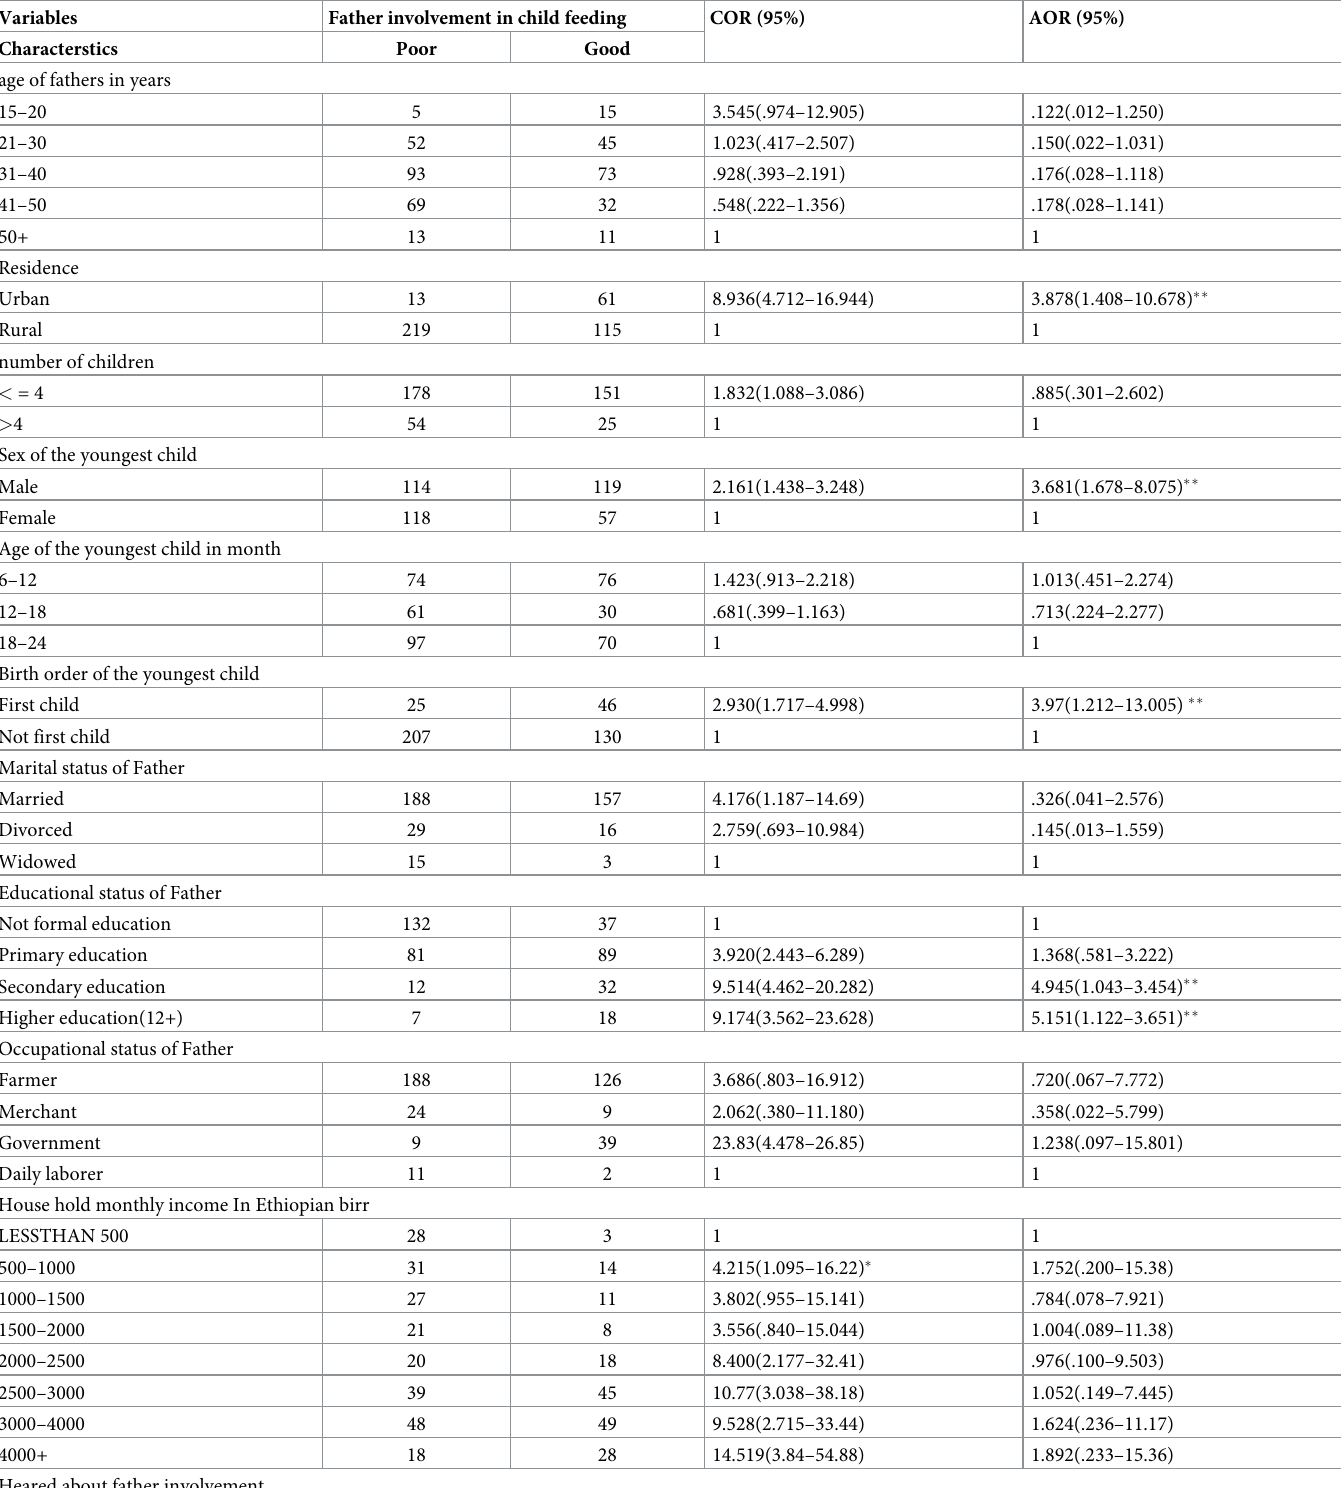
Table 6. Multivariable logistic regression model for fathers’ involvement in child feeding practice in Antsokia Gemza Wereda, North East Ethiopia,